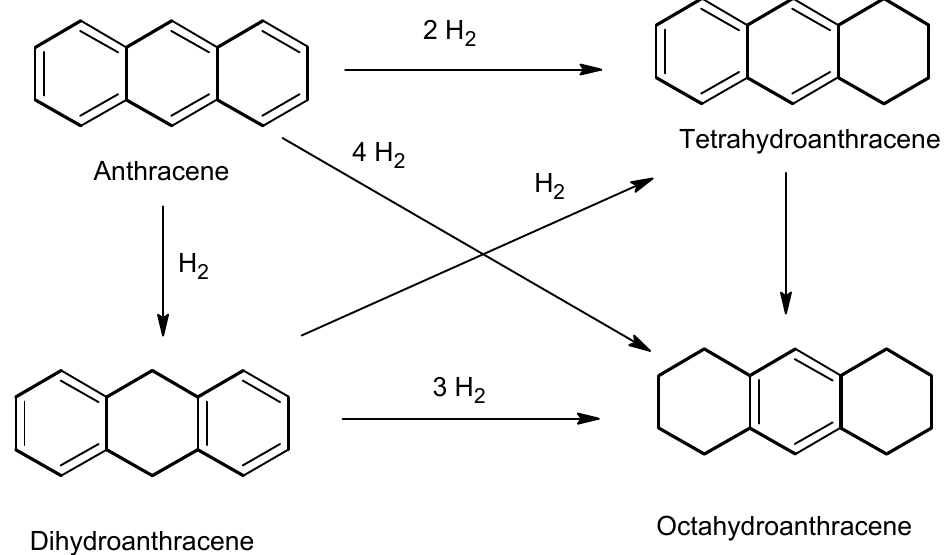
Scheme 1. Reaction pathway for hydrogenation of